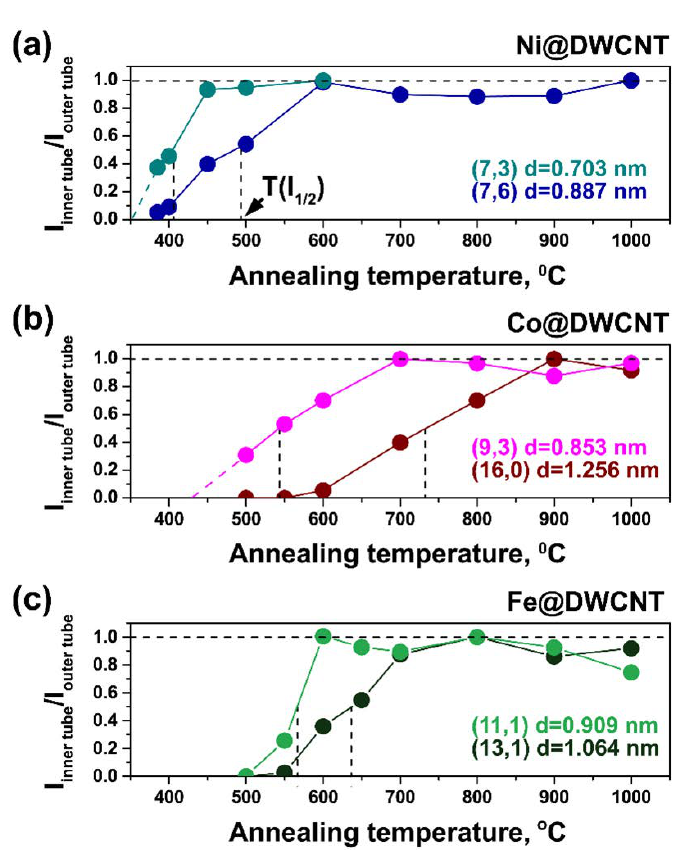
Figure 5. The normalized intensities ratio, I inner tube /I outer tube , plotted against annealing temperature for ( a ) the (7,6) and (7,3) tubes formed inside the heated nickelocene-filled SWCNTs, ( b ) the (16,0) and (9,3) tubes formed inside the heated cobaltocene-filled SWCNTs and ( c ) the (13,1) and (11,1) tubes formed inside the heated ferrocene-filled SWCNTs. T(I 1/2 ) is marked by dashed vertical lines. The temperature, T(I 1/2 ), at which the intensity of the inner tube RBM peak